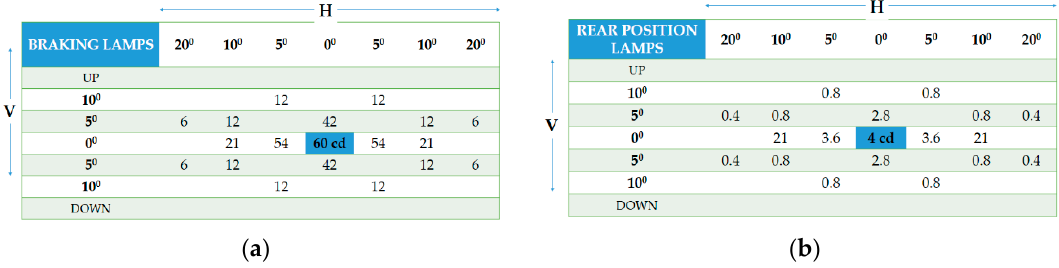
Figure 2. The photometric testing requirement of ECE R07 standard. ( a ) Braking lamps; ( b ) rear position lamp.